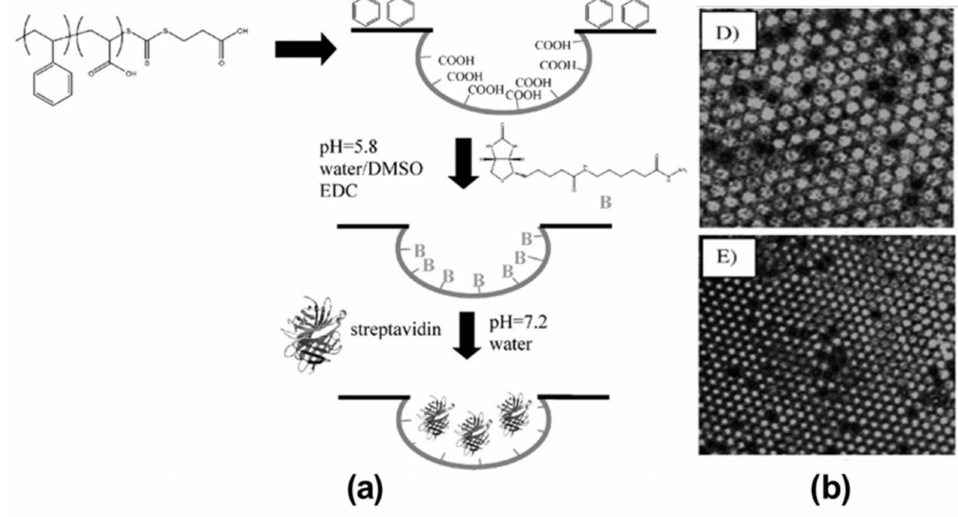
Figure 5. ( a ) Synthetic approach to a streptavidin microarray with immobilization of protein selec- tively in the pores. ( b ) Confocal microscopy images of PS-PAA honeycomb-structured porous films after modification with biotin and streptavidin. Reprinted with permission from ref. [87]. Copyright 2008 Advanced